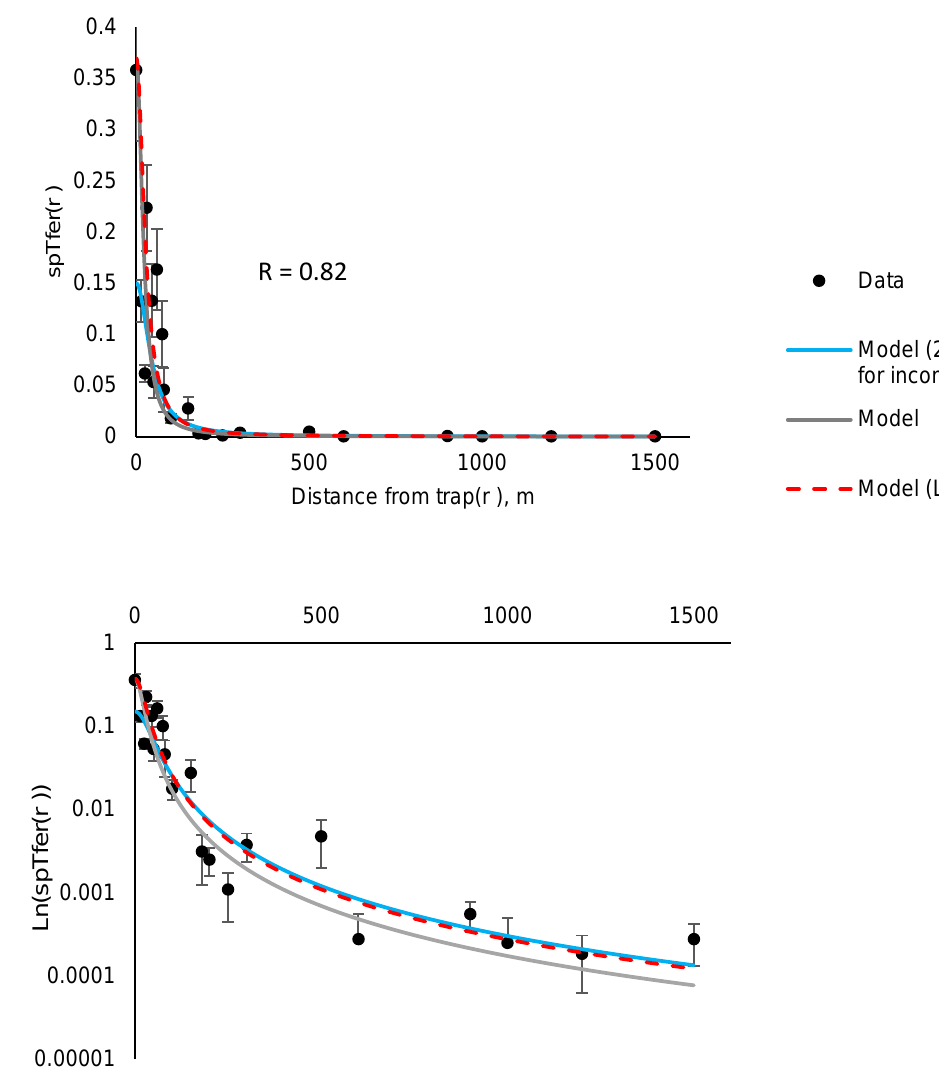
Figure 1. Proportion of L. dispar males caught in pheromone-baited traps placed at various distances from the release point ( ± SEM). Error bar is not shown when smaller than the symbol size. Panel ( A ), spT fer (r) vs. r illustrates the quality of the fit to Equation (2) at all distances; panel ( B ), ln(spT fer (r)) vs. r illustrates the fit quality at great distances from the pheromone-baited trap.